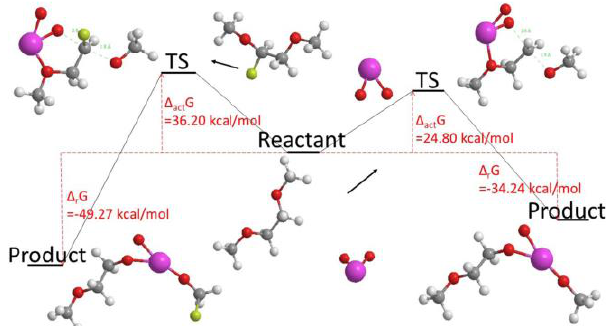
Figure 37. ( a ) Free energy as a function of Li + − O 2− aggregation and separation in EMI-TFSI and in DMSO under dilute condition. Snapshots of Li + − O 2− clusters formed in ( b ) EMI-TFSI and ( c ) DMSO after 200 ns. Adapted with copyright permission from Akagi et al. [62]. Copyright© 2016, American Chemical Society.